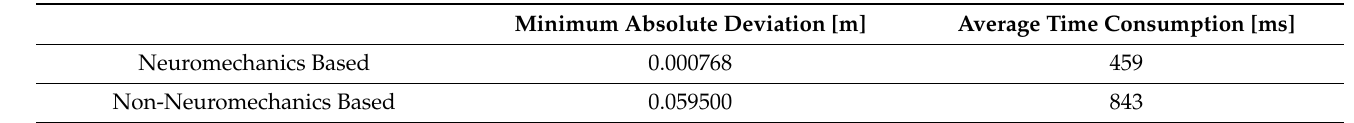
Figure 10. The neuromechanics-based neural feedback controller generates movement trajectories of the musculoskeletal arm with di ff erent parameters. Table 9. Comparison between the trajectories performed by the musculoskeletal arm model with di ff erent parameters.